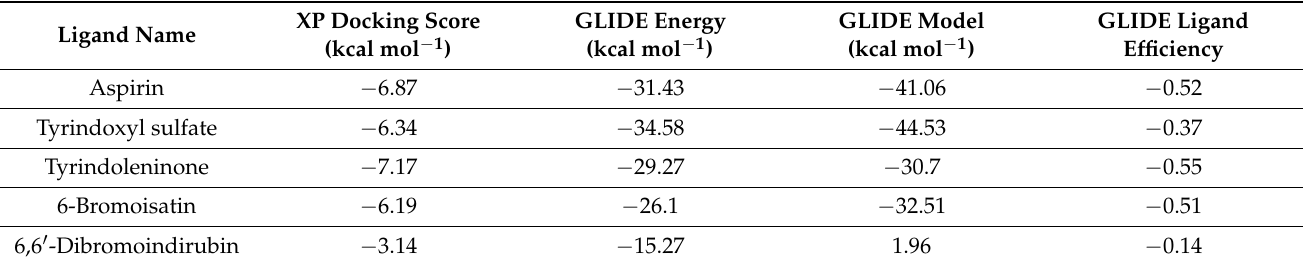
Table 2. Summary of molecular docking analysis and XP-score results from Schrodinger (Maestro v11.6) for COX-2 (PDB ID: 5IKR) for the reference molecule aspirin and four Dicathais orbita